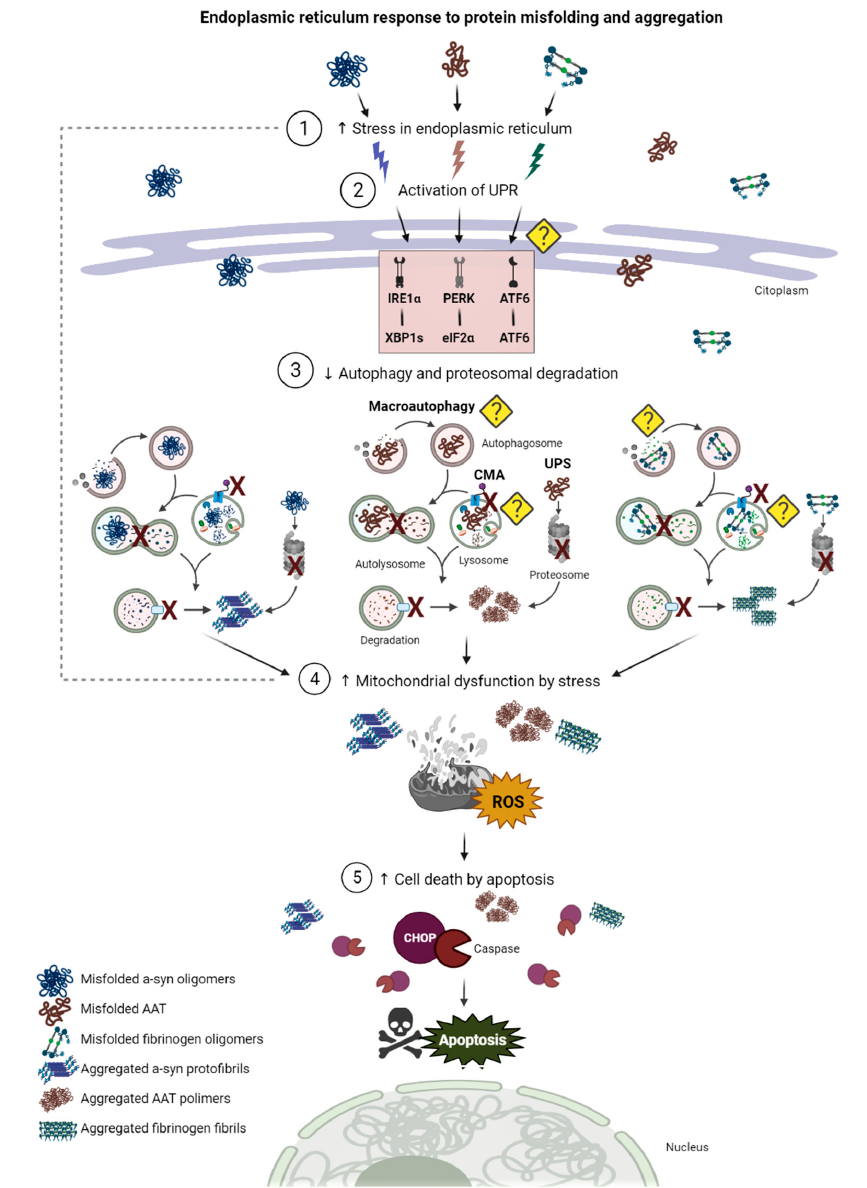
Figure 4. ER response after misfolding and aggregation of α -syn, AAT, and FG. ( 1 ) The ER increases its stress levels upon protein misfolding and aggregation produced by the dysfunction of homeostasis in the cellular milieu [208,209]. ( 2 ) The UPR system is activated by the following stress sensors IRE1- α , PERK, and ATG-6, which in turn activate the transcription factors XBP1 and eIF2 α involved in the regulation of the ER stress response and autophagy pathway-dependent degrada- tion [150,208,209]; for the case of FG, there are no studies linking UPR with FG misfolding and aggregation, however, considering the similarities of FG with AAT in terms of cellular toxicity, it is likely that similar defensive processes take place [210,211]. ( 3 ) The main degradation systems: the autophagic pathway and the ubiquitin–proteosome system (UPS) deteriorate their function in the face of increased misfolded proteins [62,130,143]. This prevents the correct degradation of proteins, causing an increase in their aggregation. Within the autophagic pathway, in the case of α -syn, macroautophagy and CMA are known to mediate the degradation of this protein upon misfolding [69]. In contrast, for the case of AAT and FG, the types of autophagy involved in their degradation have not yet been elucidated [114,116,195]. ( 4 ) In parallel, there is an increase in mitochondrial stress, which affects its UPR function upon α -syn (dotted line) [176], AAT [181], and FG